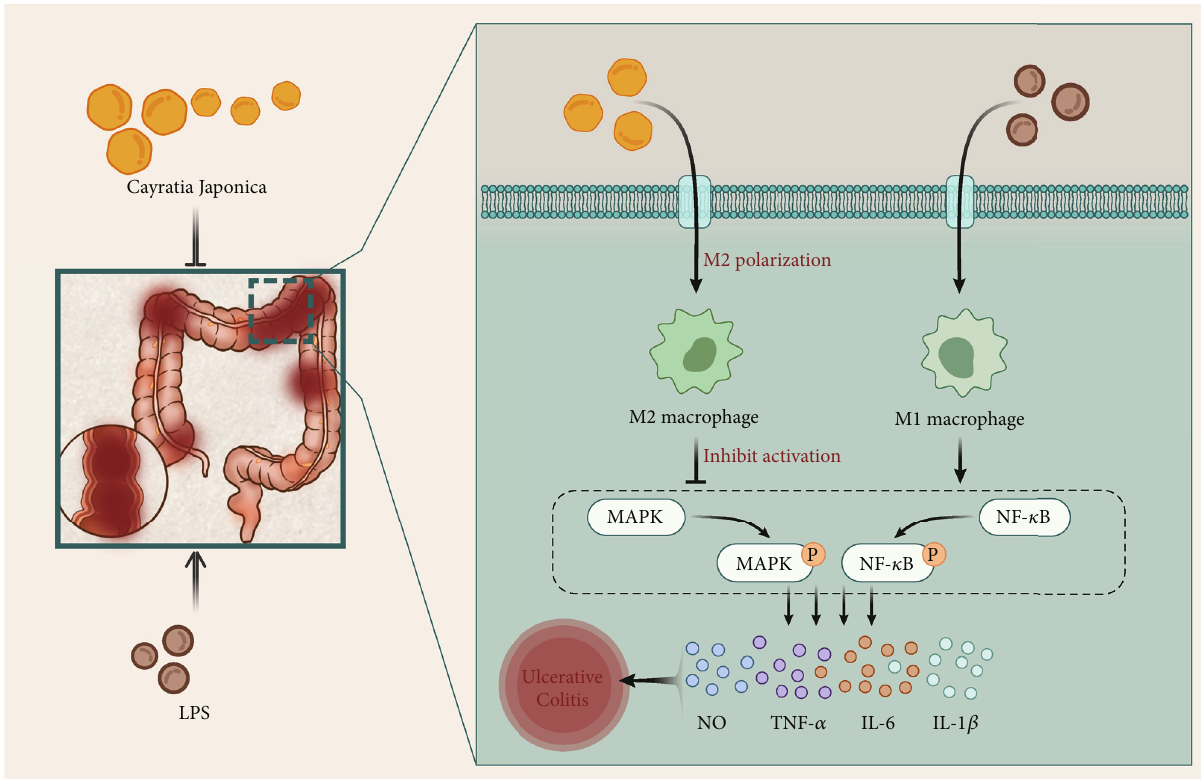
Figure 7: Schematic representation of the molecular mechanisms by which CJ regulates macrophage polarization a ff ecting UC development via the TLR4/MAPK/NF- κ B